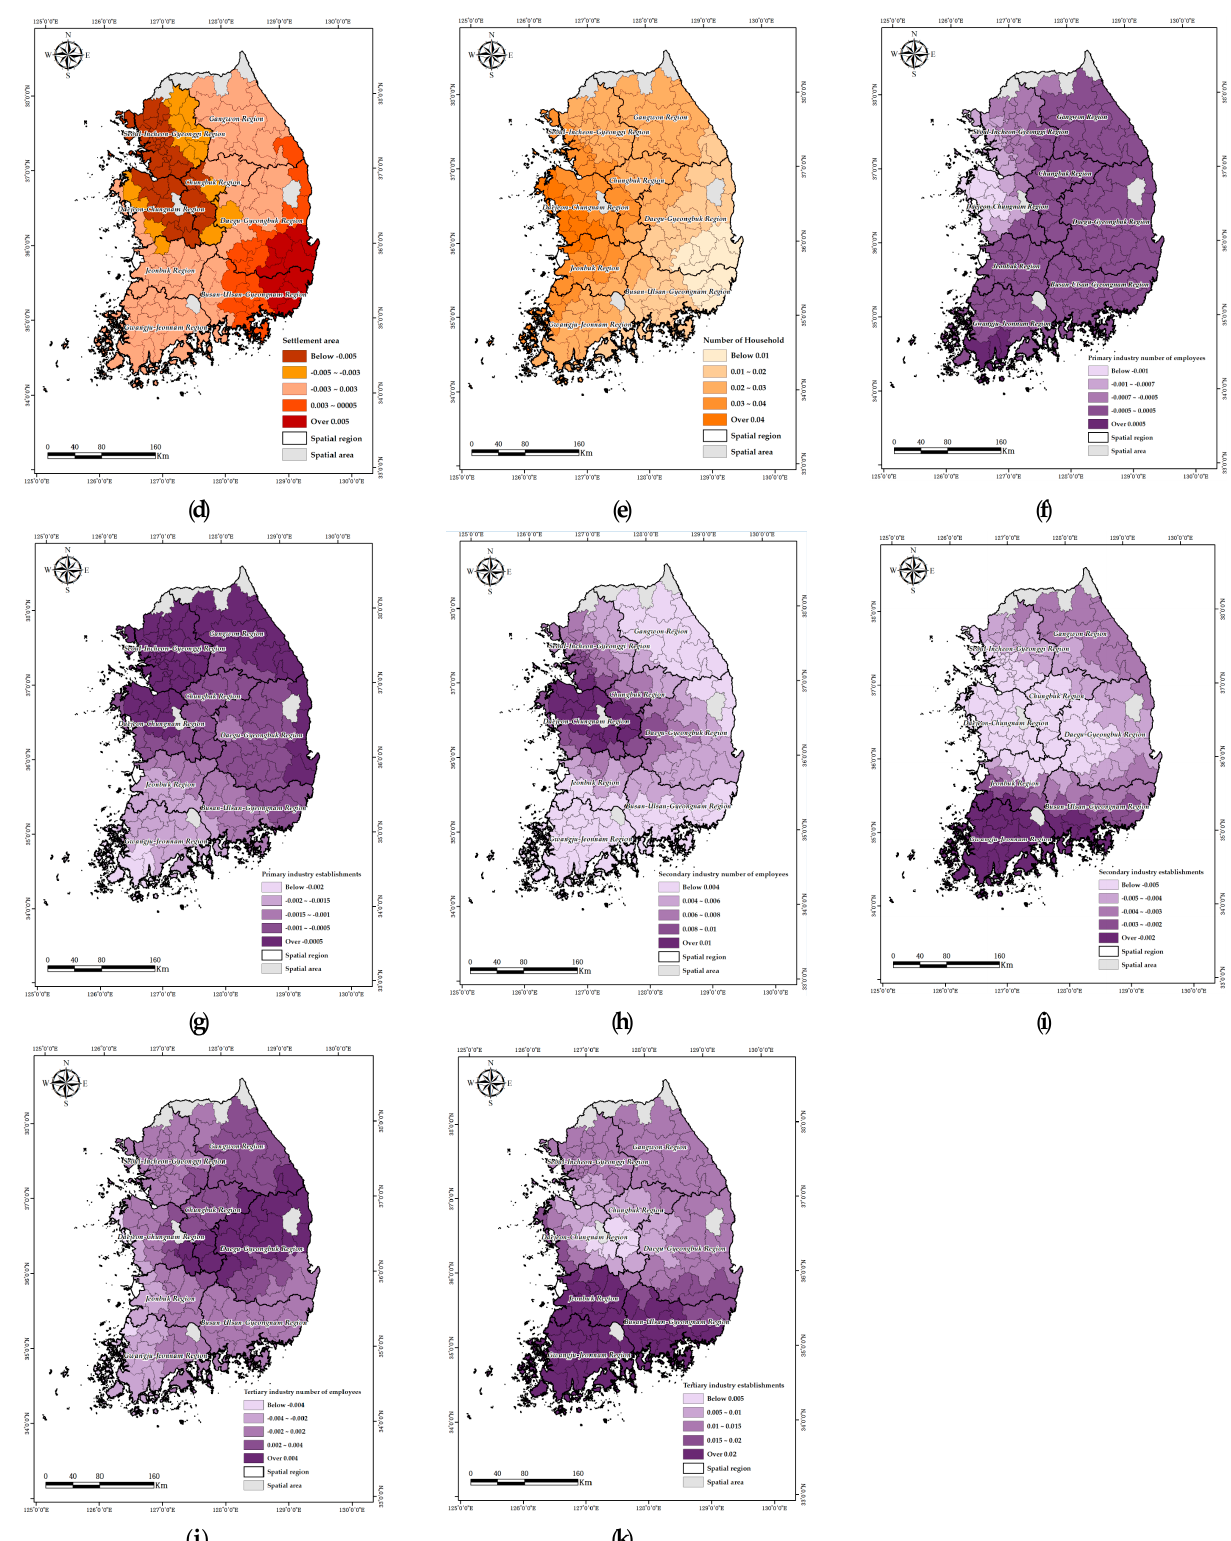
Figure 7. Distribution map of regression coefficients for the forest loss impact factors in the GWR model: ( a ) road density, ( b ) cropland area, ( c ) grassland area, ( d ) settlement area, ( e ) number of households, ( f ) primary industry number of employees, ( g ) primary industry establishment, ( h ) secondary industry number of employees, ( i ) secondary industry establishment, ( j ) tertiary industry number of employees, and ( k ) tertiary industry establishment.